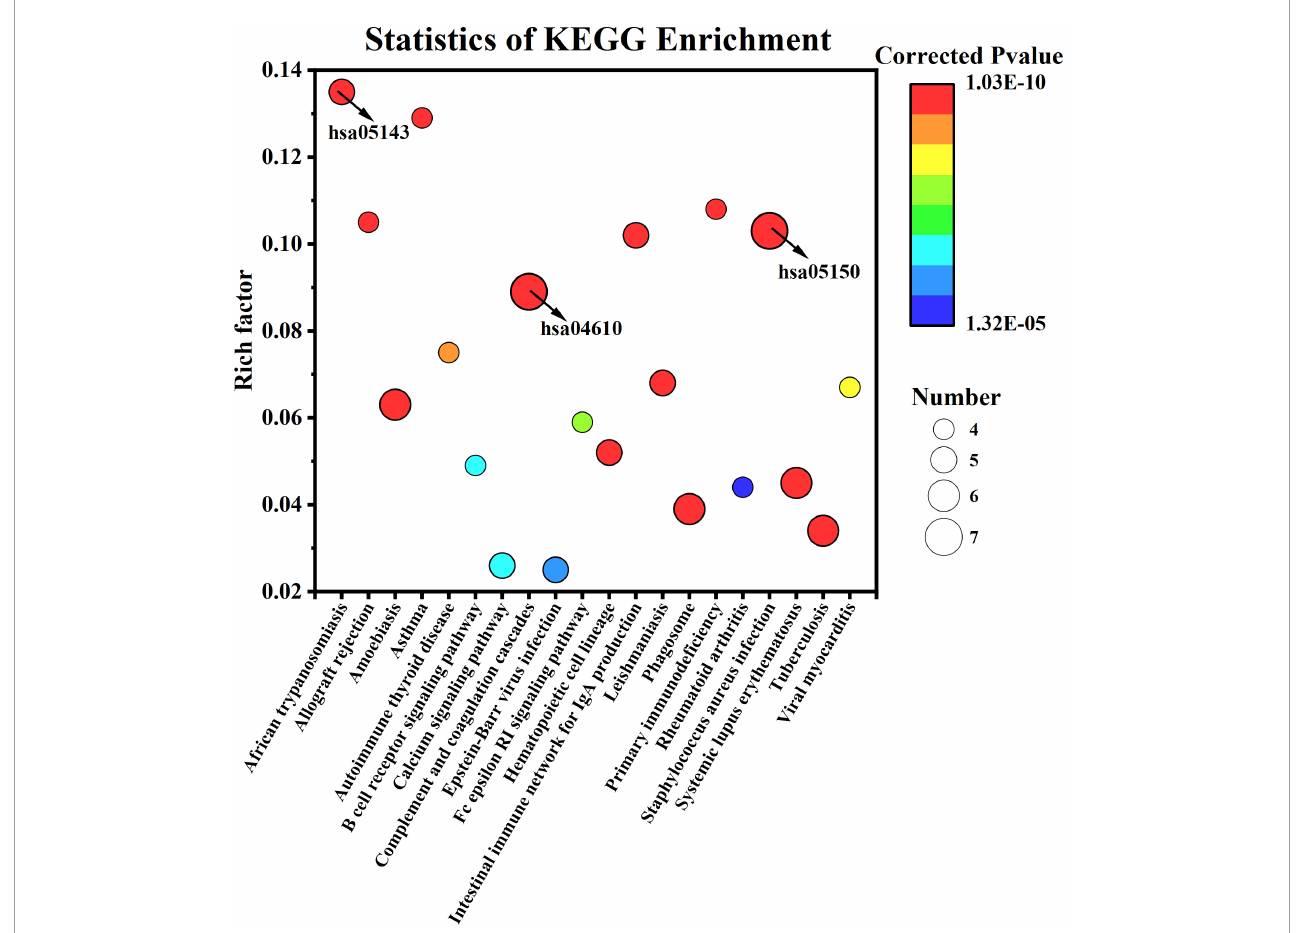
FIGURE8 Kyoto Encyclopedia of Genes and Genomes pathway enrichment of differentially expressed caseins from Korean and Han ethnic groups in